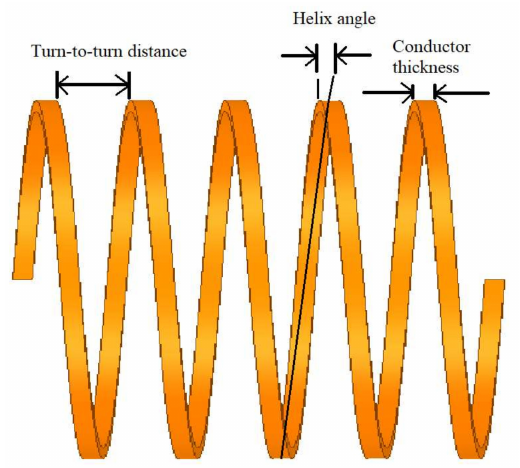
Figure 9. Layer of the winding depicting helix